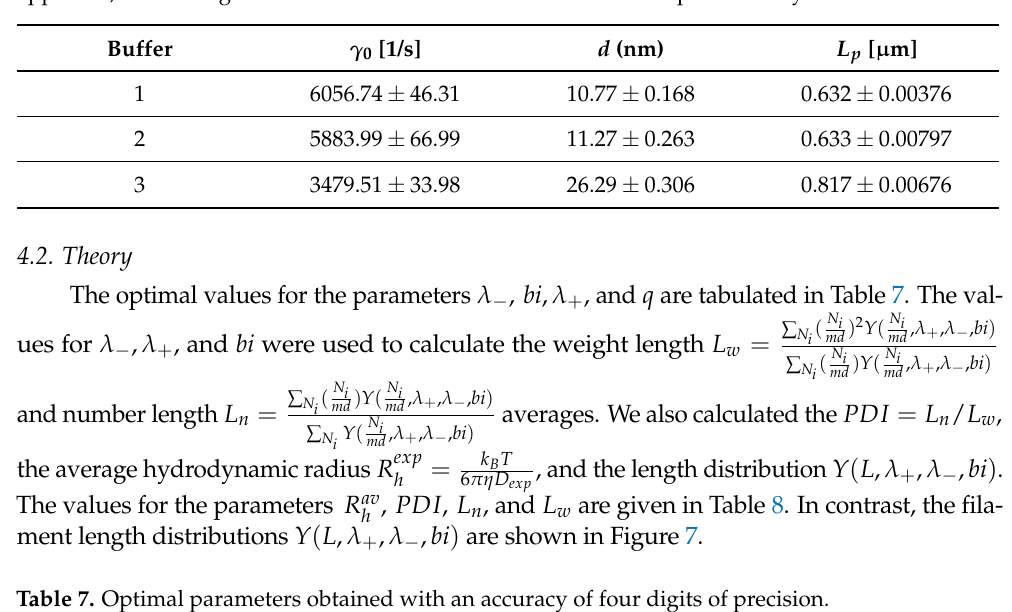
Table 6. Average values and fitting errors obtained for the initial decay rate ( γ 0 ), the hydrodynamic diameter ( d ), and the persistence length ( L p ) parameters using Equations (21) and (22), a fitting curve approach, and the eighteen correlation data functions measured experimentally for each buffer.